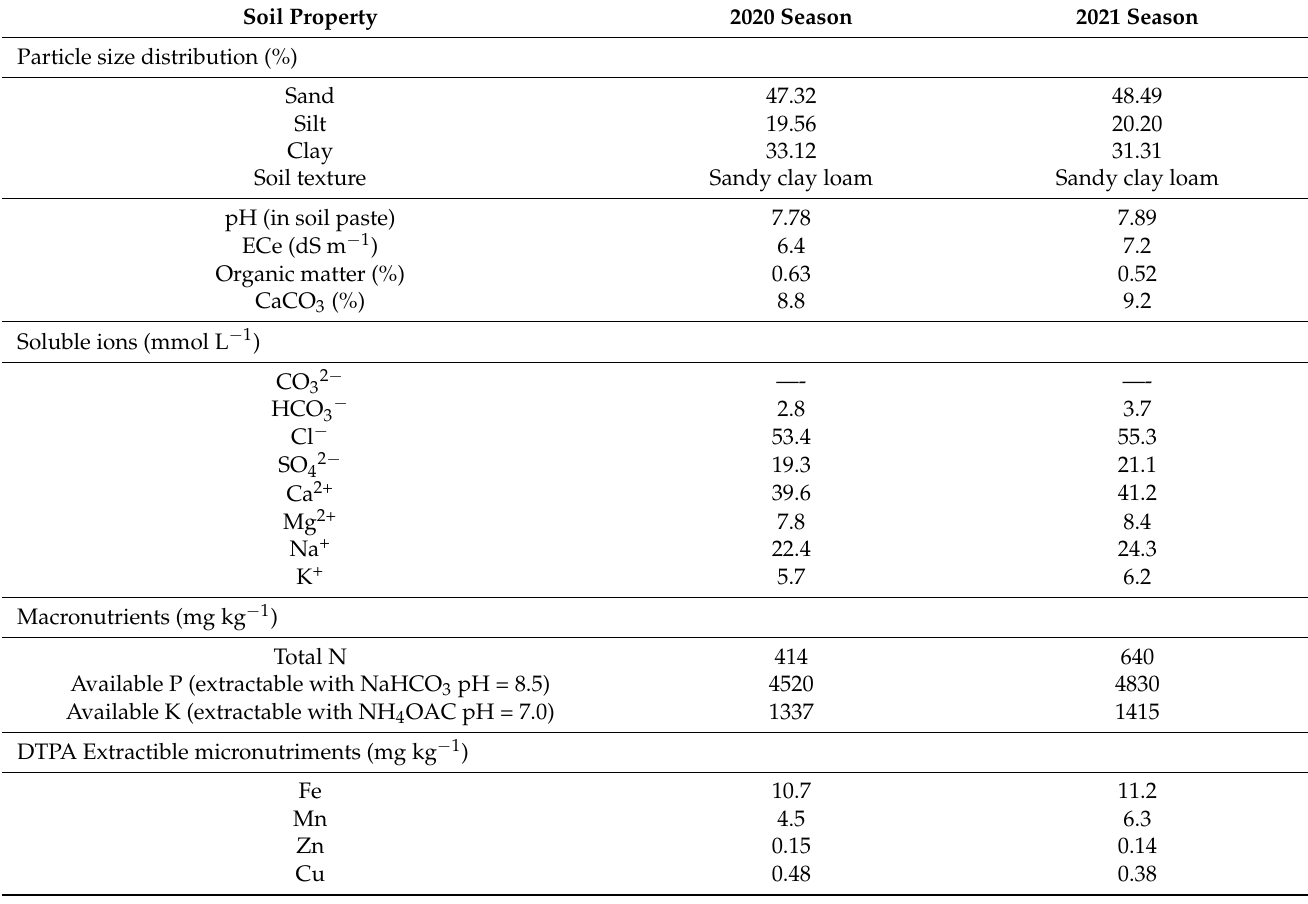
Table 3. Some soil chemical and physical